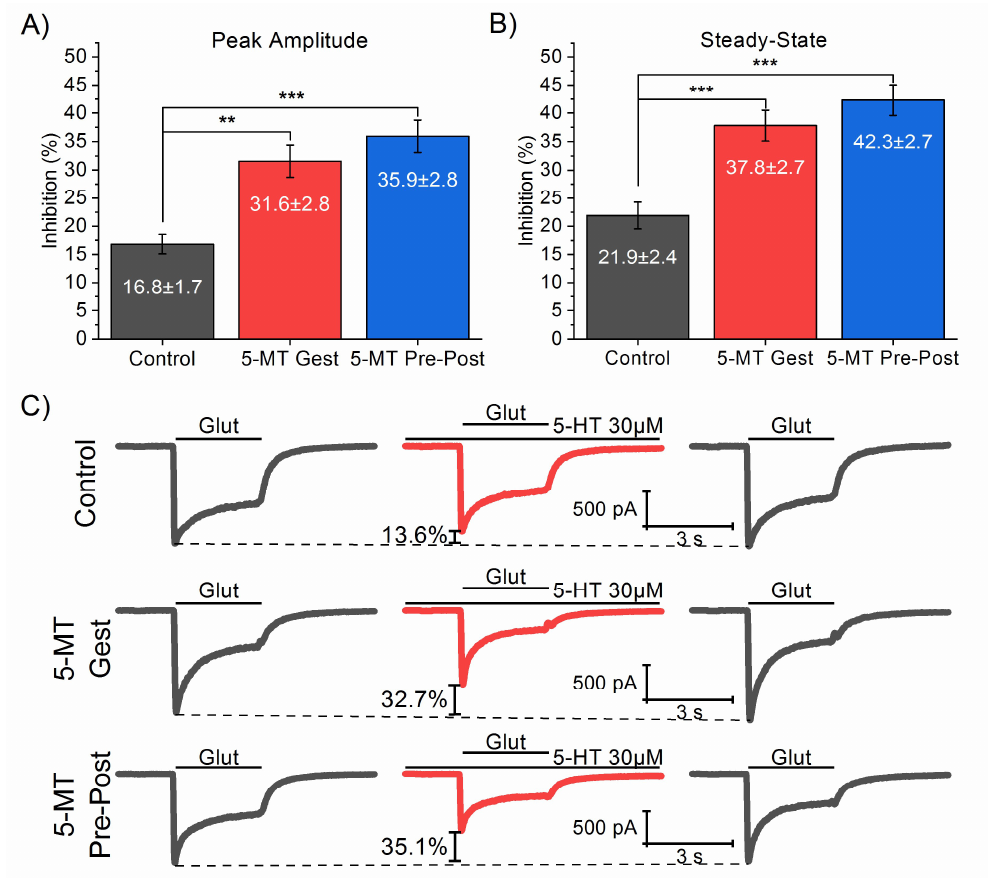
Figure 2. Comparison of the e ff ect of di ff erent 5-methoxytryptamine (5-MT) administration times on I Glut in the presence of serotonin (5-HT). We conducted a one-way between-groups ANOVA to compare the e ff ect on I Glut (100 µ M) peak amplitude ( A ) and SS ( B ) on the presence of 5-HT (30 µ M) in the groups of treatment 5-MT Gest (GD11–GD21; n = 10), 5-MT Pre-Post (GD11–PND21; n = 13), and control ( n = 12). Significant di ff erences were found on both current components (Peak amplitude: F 2,32 = 16.18; p < 0.001. SS: F 2,32 = 17.88; p < 0.001) for both treated groups from the control but not between them. ( C ) Representative traces of I Glut in the presence and absence of 5-HT from pyramidal neurons from each group tested. Significant differences among groups are indicated according to the following significance code: p < 0.001 (***), p < 0.01 (**), p < 0.05 (*). Table 1. Post-hoc comparisons among groups using the Tukey test ( p < 0.05).